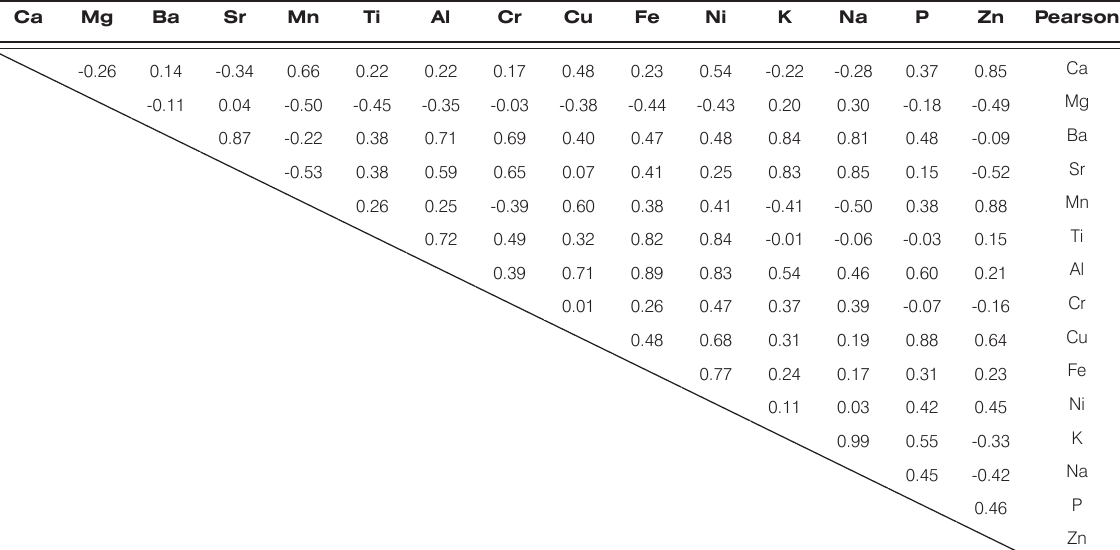
Table 4. Pearson correlation coefficients in all samples.